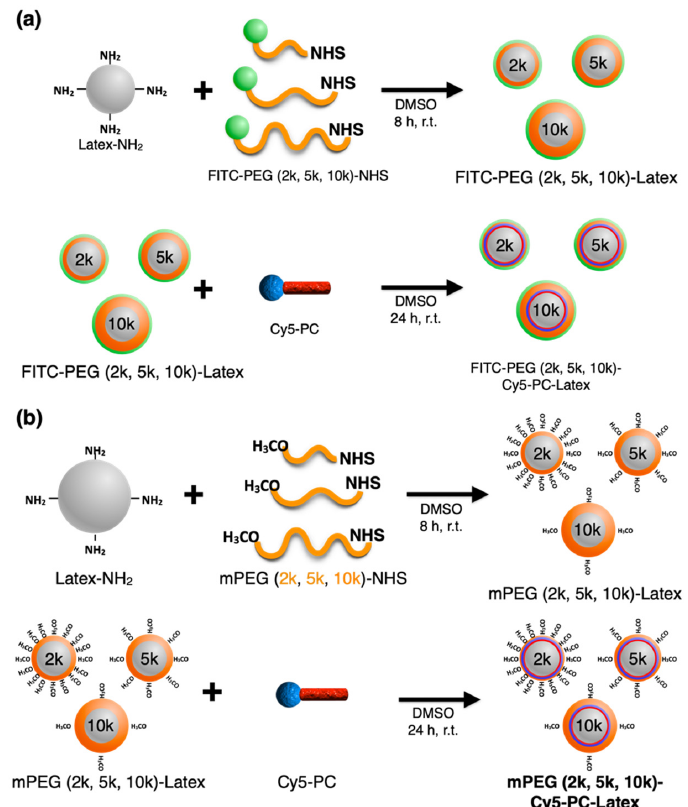
Figure 1. Schematic illustration of PEGylated Cy5-PC-Latex bead fabrication. ( a ) Fabrication protocol of FITC-PEG (2k, 5k, 10k)-Cy5-PC-Latex. ( b ) Fabrication protocol of mPEG (2k, 5k, 10k)-Cy5-PC-Latex.